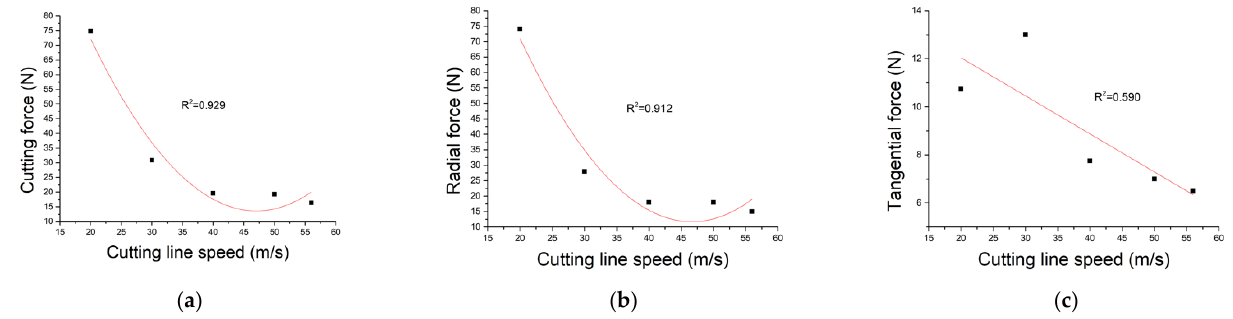
Figure 3. ( a ) Effect of cutting line speed on cutting force; ( b ) effect of cutting line speed on radical force; ( c ) effect of cutting line speed on tangential force.